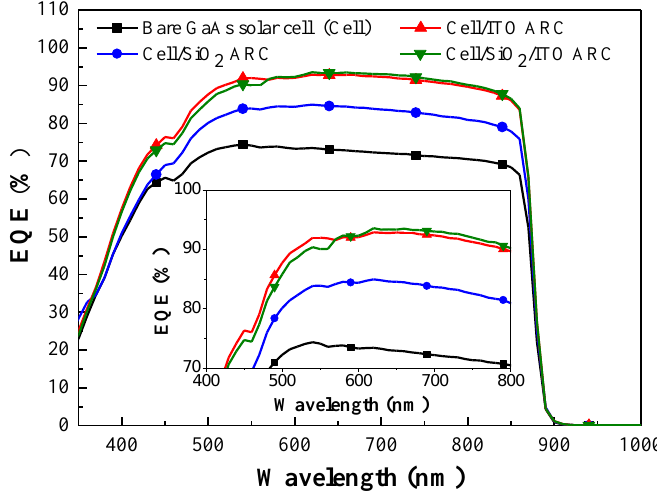
Figure 7. EQE response of bare GaAs solar cell and GaAs cells with ARCs of SiO 2 , ITO, or thin-SiO 2 /ITO.